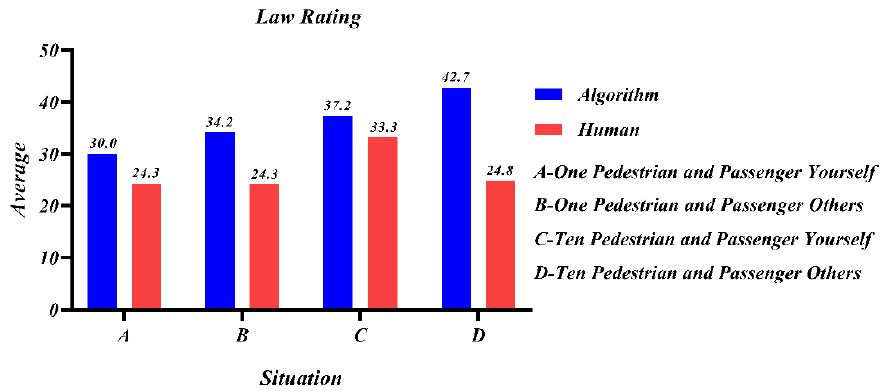
Figure 9. Mean of participants’ evaluation scores of legally enforced swerving in different situations.